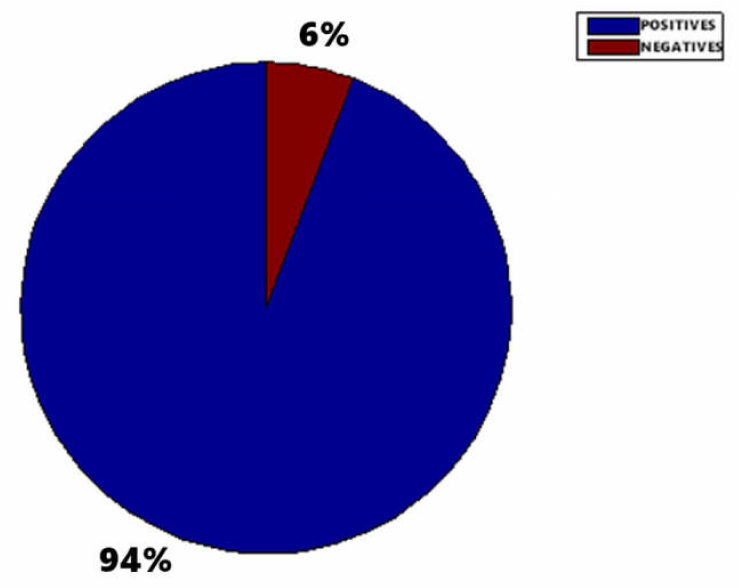
Figure 15. MONICOD validation. All the cans are correct (465) so the 6% (27) of cans that have been negatively validated is erroneous. However, of these 27 wrongly validated cans only one can (0.21%) was caused by the system described in this paper. The rest of the wrongly validated cans were due to errors in the elliptical histogram algorithm, band division and ink fragment grouping (see